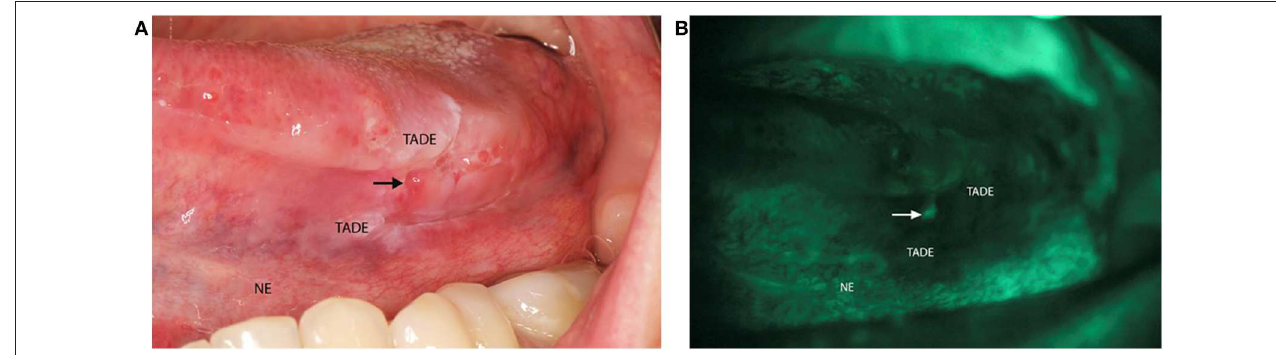
FIGURE 1 | Clinical photo of VELscope ® oral cancer screening of a patient. (A) Image of a patient with a squamous cell carcinoma on the left side of the tongue presenting as an ulcer (arrow). The tumor adjacent dysplastic epithelium (TADE) that showed loss of fluorescence with the VELscope ® is present around the ulcer with the distant clinical normal epithelium (NE) that did not show loss of fluorescence. (B) Photograph of the VELscope ® analysis showing the ulcer (arrow) with surrounding TADE with loss of autofluorescence and NE showing normal autofluorescence. (Number of patients screened = 5).